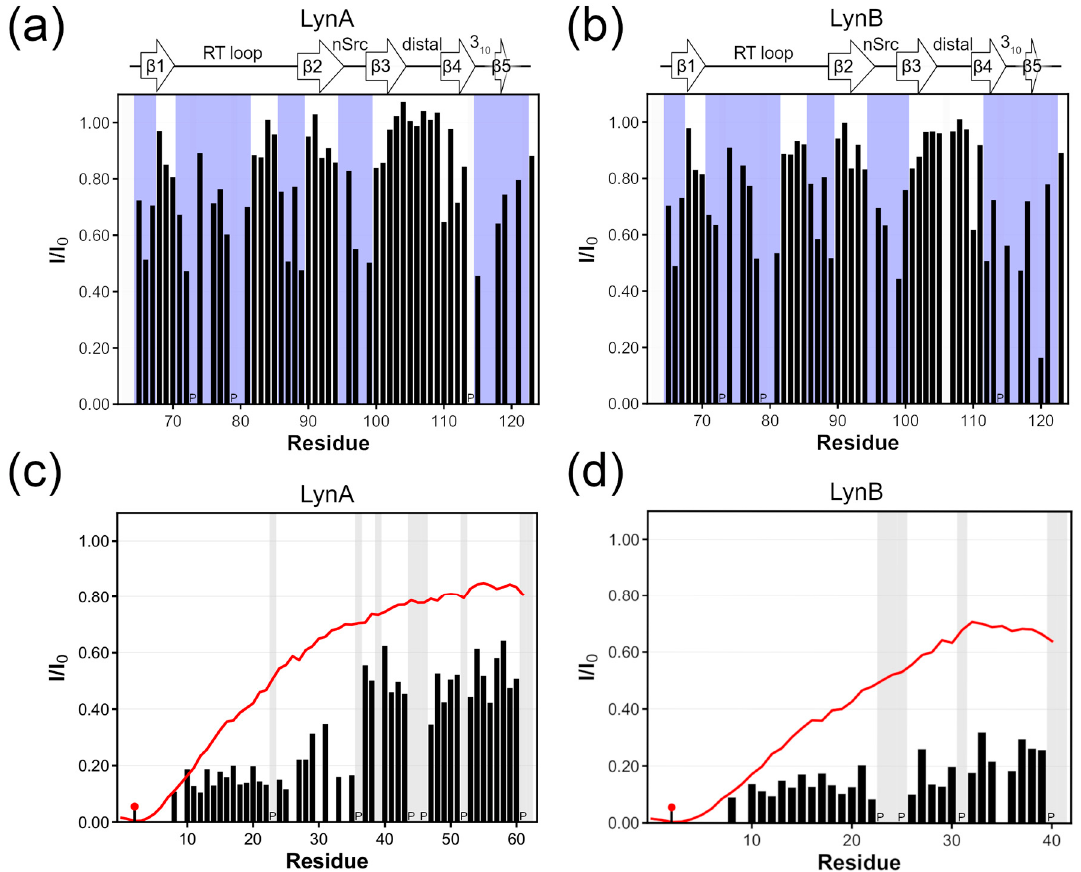
Figure 4. Paramagnetic Relaxation Enhancement (PRE) effects of MTSL paramagnetic probe attached at cysteine 3. ( a ) Intensity ratios observed in the SH3 domain of LynA USH3 construct between the paramagnetic and the diamagnetic sample. ( b ) Same as ( a ) but for LynB USH3 construct. The blue shadow in ( a , b ) highlights the continuous sequence regions with I/I 0 below 0.8 bound by two consecutive residues passing the threshold. ( c ) PRE effects observed within the LynA SH4-Unique domains for the USH3 construct. ( d ) same as ( c ) but for LynB isoform. In ( c , d ) a pin marks the position of the tag; in red the theoretical PRE profile considering the SH4-Unique as a random coil. Proline residues are identified with a letter “P”.